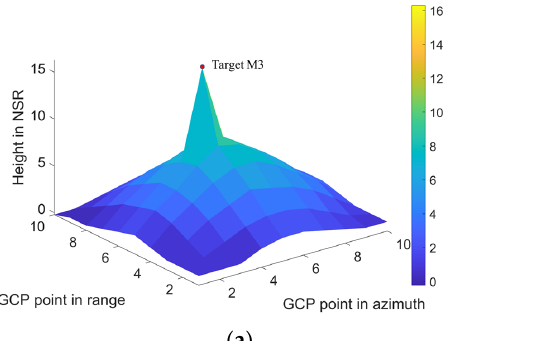
Figure 21. Schematic diagram of the 1st, 2nd, and 3rd in 20 SAR images ( v x = 2 m/s).